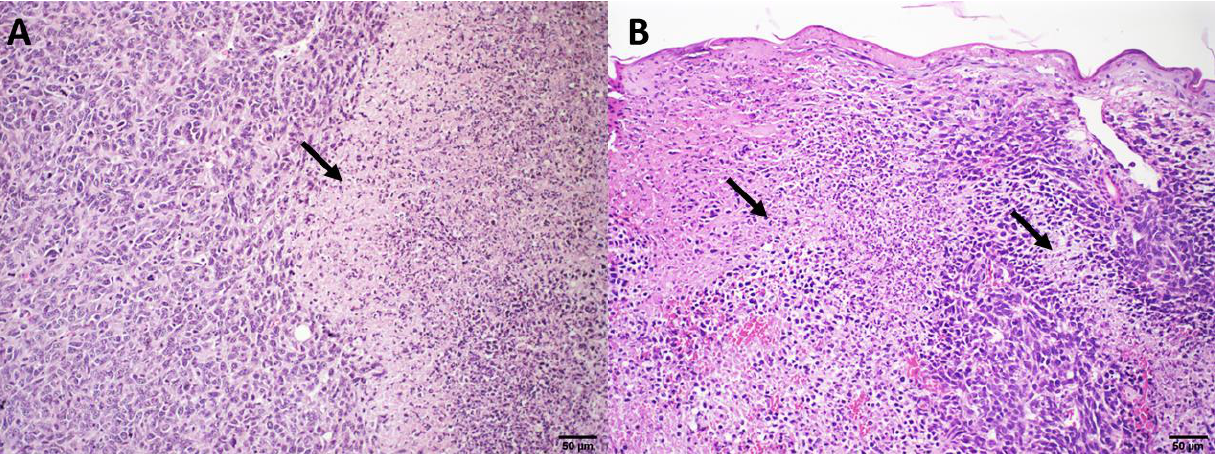
Figure 5. Representative photomicrographs of histological sections of the primary tumors of female Balb/c mice bearing 4T1 breast tumors treated with ( A ) HBS and ExoSpHL. The arrow indicates the central tumor necrosis area. ( B ) DOX, SpHL-DOX, and ExoSpHL-DOX at a cumulative dose of 25 mg/kg. The arrows indicate multiple tumor necrosis areas. HE, scale bar = 50 µm.